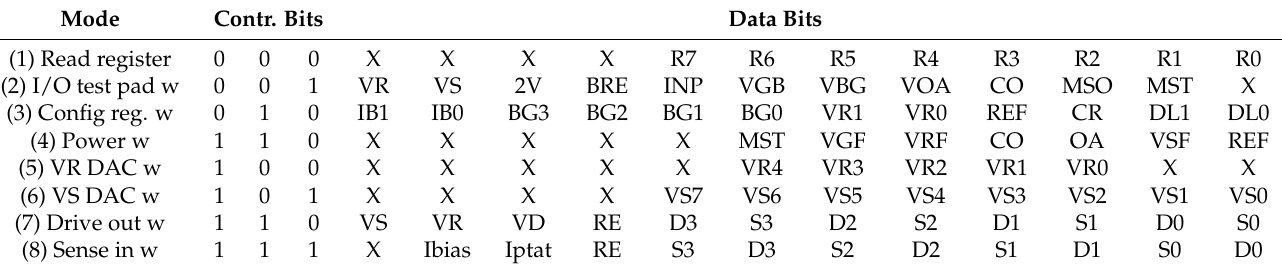
Table 2. Operation